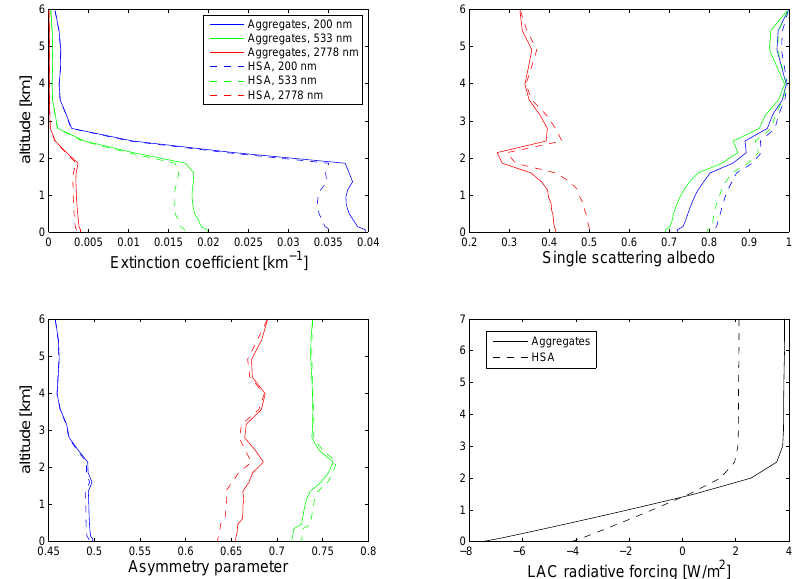
Fig. 10. Vertical profiles of extinction coefficient (upper left), ω (upper right), g (lower left), and shortwave radiative impact (lower right) computed for 25 June 2006 at a latitude of 48.2 ◦ N and a longitude of 2.3 ◦ E. The curves display computational results based on the aggregate model (solid lines) and on the HSA (dashed lines). Broadband results are represented by black lines, spectral results by blue lines (200nm), green lines (533nm), and red lines